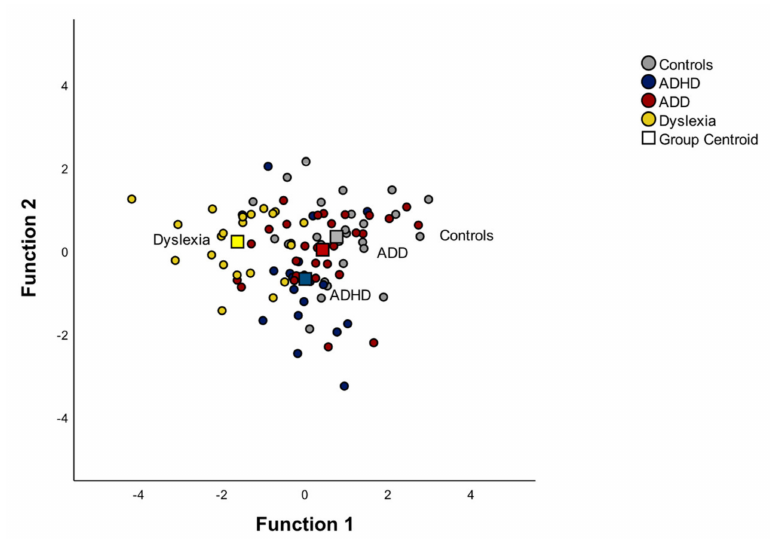
Figure 3. Discriminant function of the Musical Performance Assessment Scale. Function 1 discrimi- nates the dyslexic group from the control, ADD and ADHD groups. The correlations between the outcomes and the discriminant functions revealed that the loads onto the first function are high for the rhythmic improvisation (r = 0.72) and musical expression (r = 0.67).